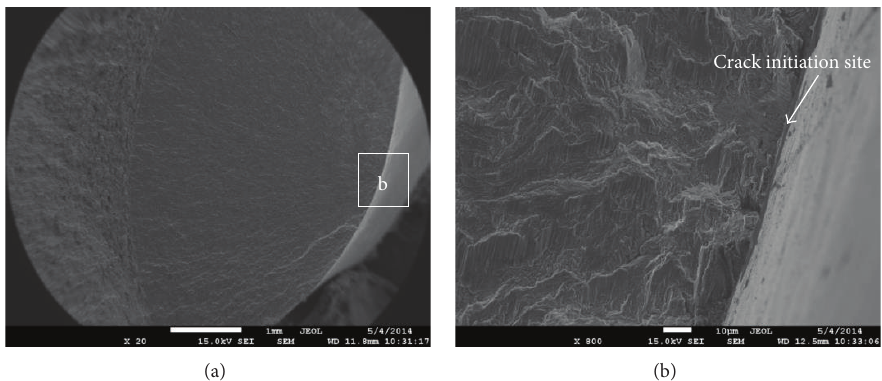
Figure 7: Typical fracture surface of the smooth UCN: (a) fracture surface and (b) crack initiation site.